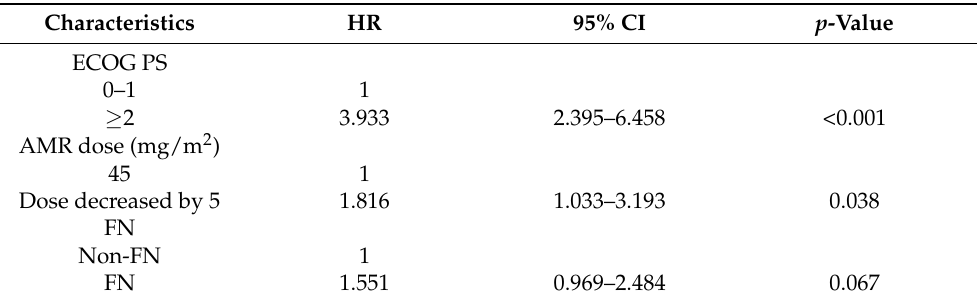
Table 4. Potential risk factors for OS by the multivariate Cox proportional hazards analysis ( N = 156). Characteristics